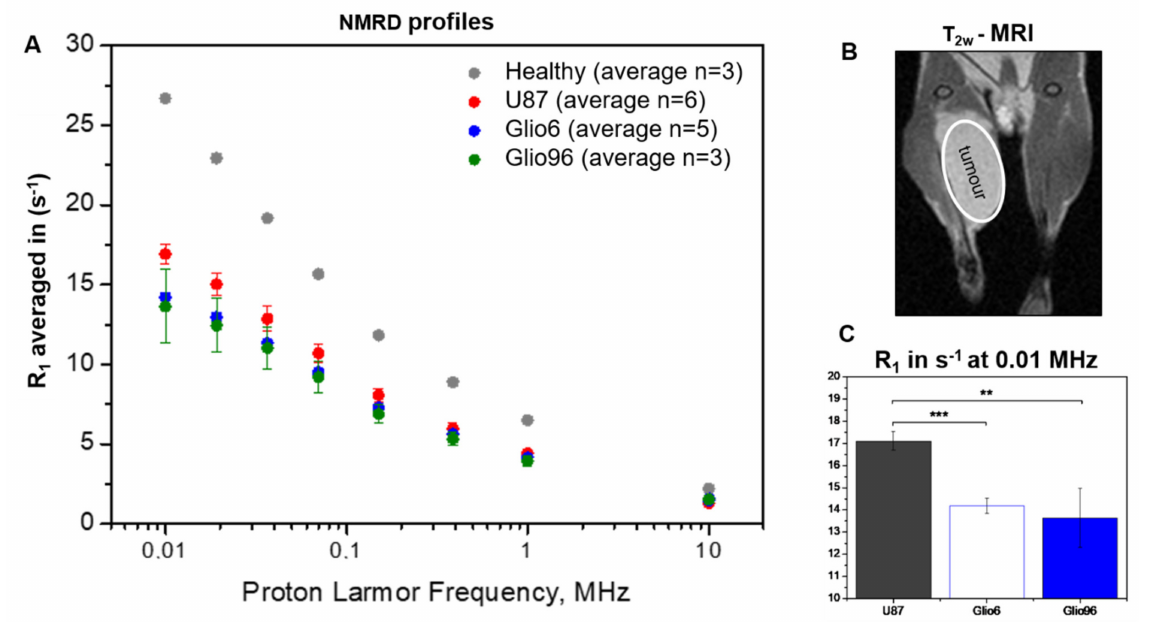
Figure 1. FFC-NMR characterization of glioma mouse models in vivo. ( A ): “In vivo” NMRD profiles of invasion (Glio6, Glio96), proliferation (U87) glioma models, and healthy hind limb muscle tissues. ( B ): Typical T 2W -MRI showing the tumor region in the mouse leg when acquired by FFC-NMR in vivo (case of Glio6). ( C ): R 1 values at 0.01 MHz observed for Glio models (invasion) and U87 (proliferation). Error bars represent the standard error of the experimental data (*** p < 0.001, ** p < 0.01). In Figure 2A, R 1 values of the tumor tissue (R 1tum ) were derived by applying Equa- tion (1).